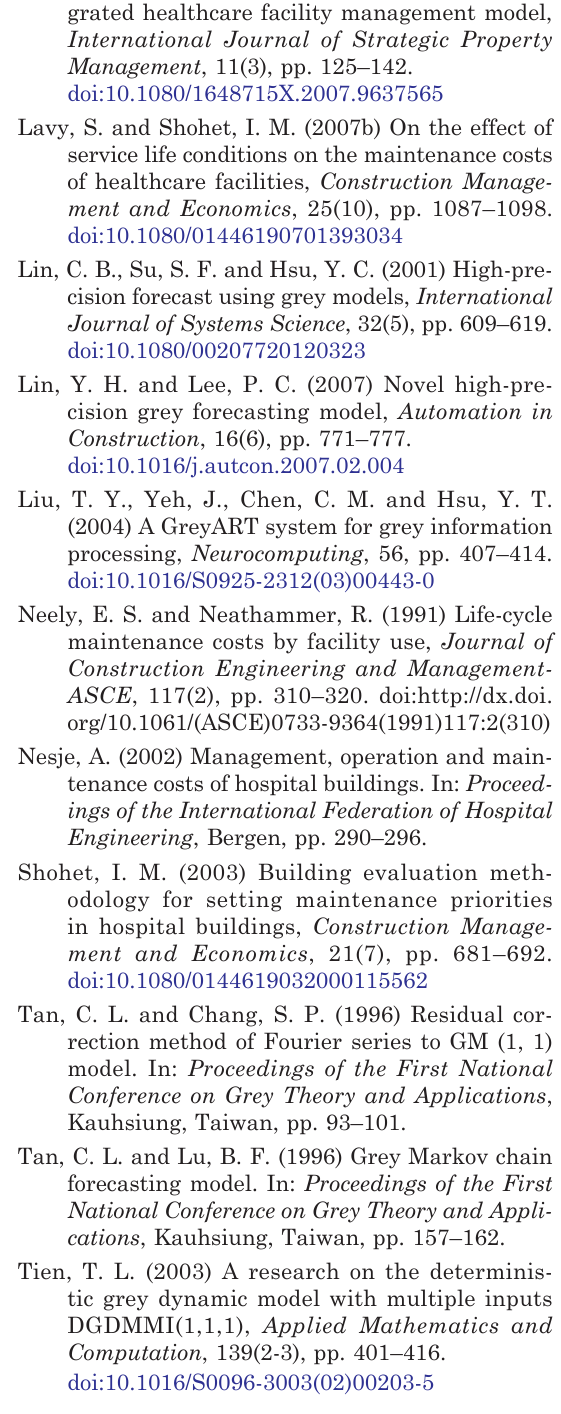
391 Application of the Exponential Grey Model on the Maintenance Cost Prediction